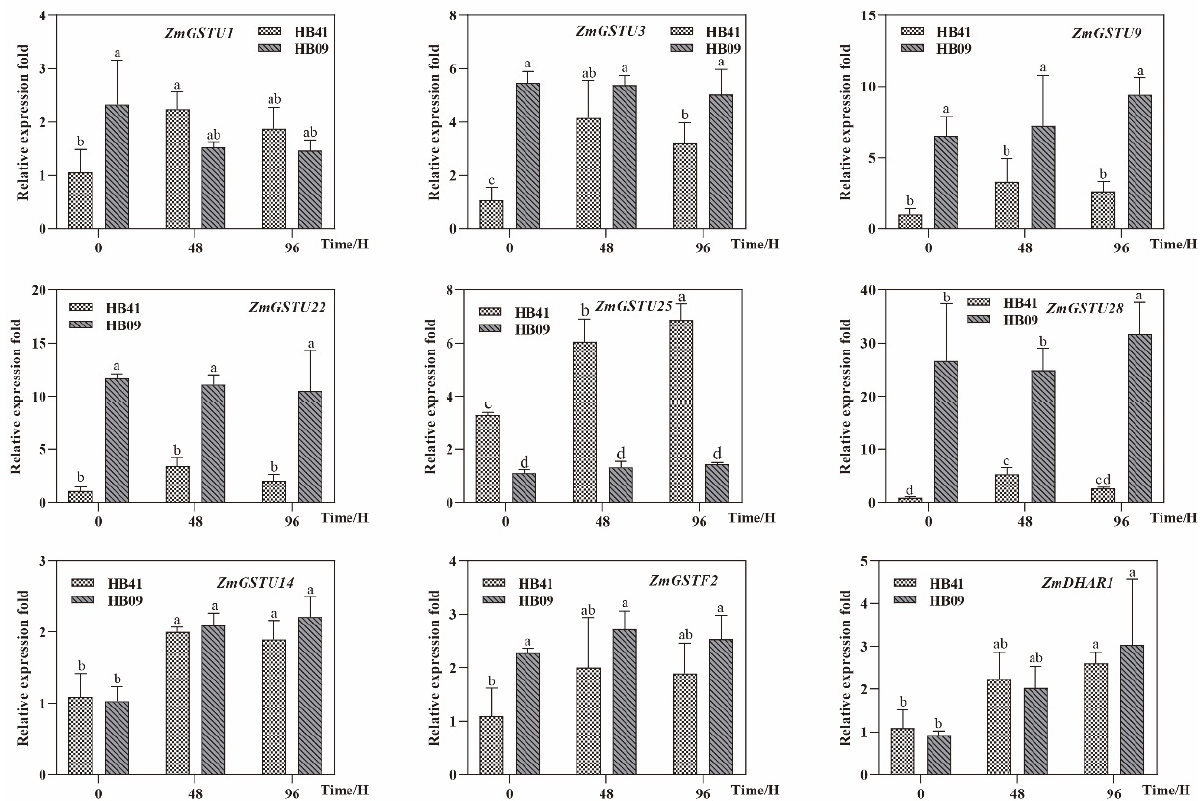
Figure 6. Relative expression of the nine selected glutathione S-transferase genes in two maize genotypes after 60 g a.i. ha − 1 nicosulfruon treated 0, 48, and 96 h using quantitative real-time PCR. Expression levels were normalized to UPF1, and error bars represent the standard deviation of the means of three independent replicates. Different letters above the error bars show significant differences at p < 0.05 based on Duncan’s multiple range tests.